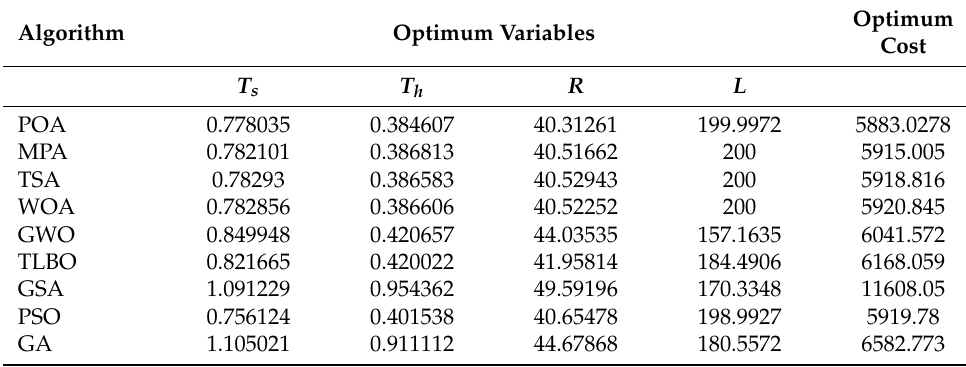
Table 9. Comparison results for pressure vessel design problem.